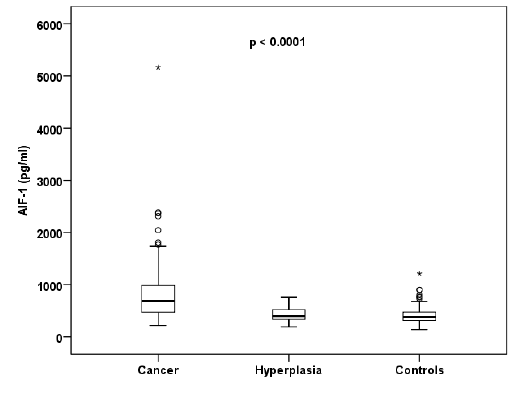
Figure 2: S100-A11 serum levels in endometrial cancer (cancer, n=98), endometrial hyperplasia (hyperplasia, n=43), and normal endometrium (controls, n=91) patients.